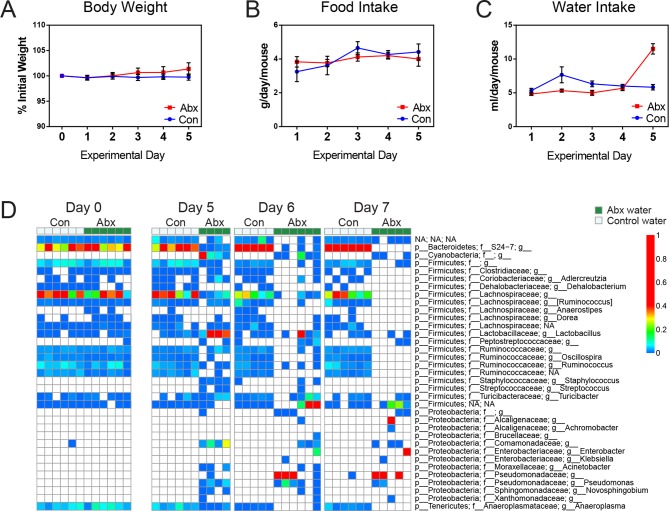
Antibiotic-treatment causes compositional changes in intestinal microbiota without affecting body weight, food intake, and water intake in C57BL/6 mice.Mice were subjected to antibiotic water (Abx, neomycin and vancomycin) or control water (Con) for 5 days (blue-shaded) and the body weight, food intake, and water intake were monitored daily. Fecal pellets were collected for the analysis of microbiota composition. Body weight (A), Food intake (B), and Water intake (C) are not affected by antibiotic treatment. Note: on day 5, animal cages were changed by facility staff and the movement caused water loss. N=6/group. Mean ± S.E.M. shown. (D) Heat map of the longitudinal analysis of bacterial lineages detected in feces of control (light green) or antibiotic treated (dark green) mice before (day 0) and after (Dday 5, 6, and 7) treatment. Each column represents one individual mouse of the time and treatment group indicated. Microbial composition is shifted in the Abx group but is stable in Con group. The proportions of bacterial lineages are indicated by the color code to the right.